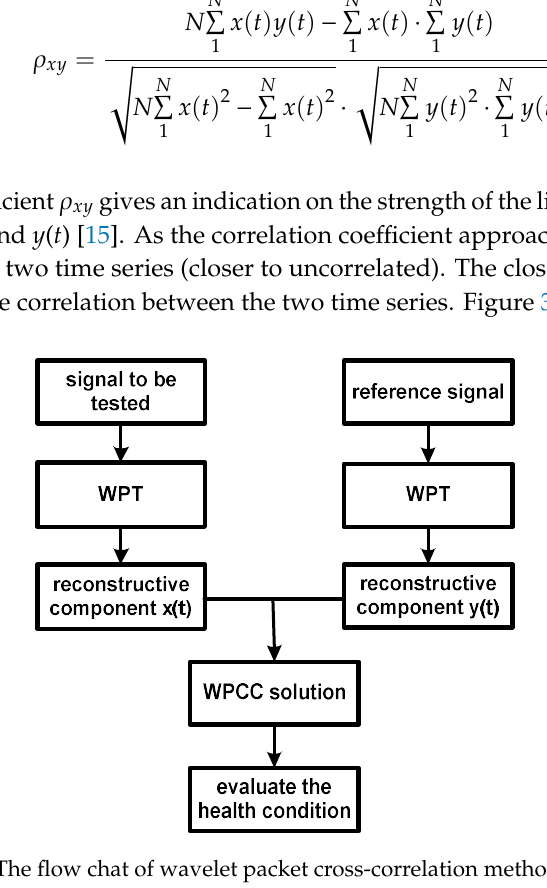
Figure 3. The flow chat of wavelet packet cross-correlation method (WPCC).